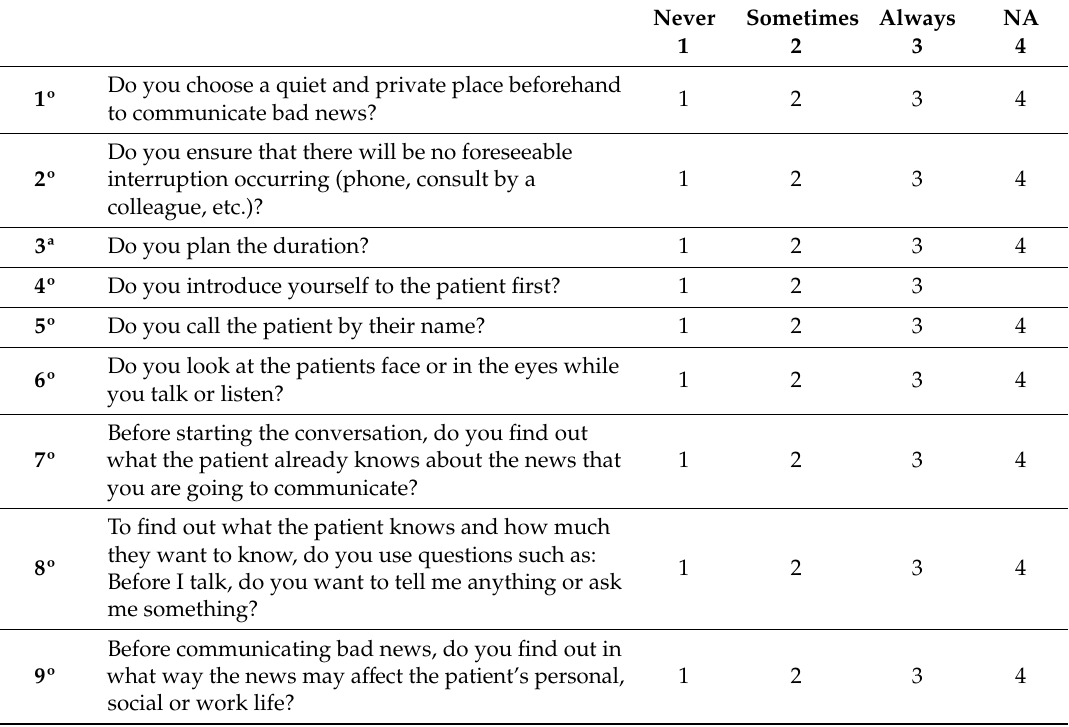
Table 5. Nursing questionnaire on communicating bad